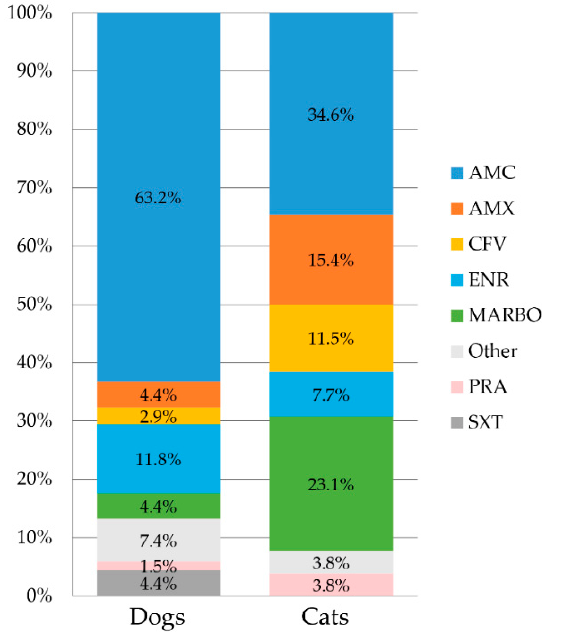
Figure 2. Percentages of antimicrobial substances used for the treatment of UTI in 43 dogs and 9 cats based on questionnaire data. Amoxicillin/clavulanic acid (AMC), amoxicillin (AMX), cefovecin (CFV), enrofloxacin (ENR), marbofloxacin (MAR), pradofloxacin (PRA), trimethoprim-sulfamethoxazole (SXT), and others (florfenicol, doxycycline, and unknown antibiotic